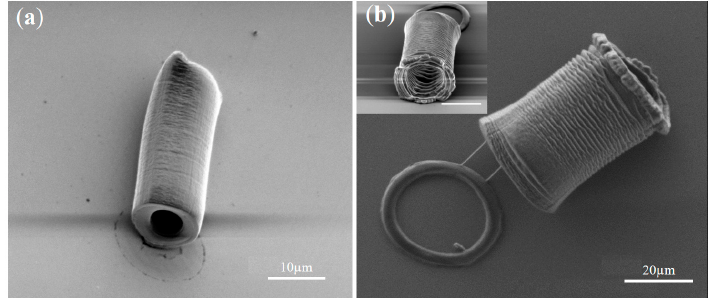
Figure 5. eSEM images of hydrogel microtubes. ( a ) A PEGDA hydrogel tube with a length of approximately 20 µm, an outer diameter of approximately 10 µm, and an inner diameter of approximately 5 µm. Optical pattern projection time is 200 s with applied voltage AC 10 V pp , the equivalent electric field value is 0.2 V pp /µm, and frequency is 10 kHz. ( b ) A PEGDA hydrogel tube with a length of approximately 35 µm, an outer diameter of approximately 25 µm, and an inner diameter of approximately 20 µm. Optical pattern projection time is 320 s, apply voltage is AC 10 V pp , the equivalent electric field value is 0.2 V pp /µm, and frequency is 10 kHz. The inset image is a tilted view of the PEGDA hydrogel tube, scale bar: 20 µm.